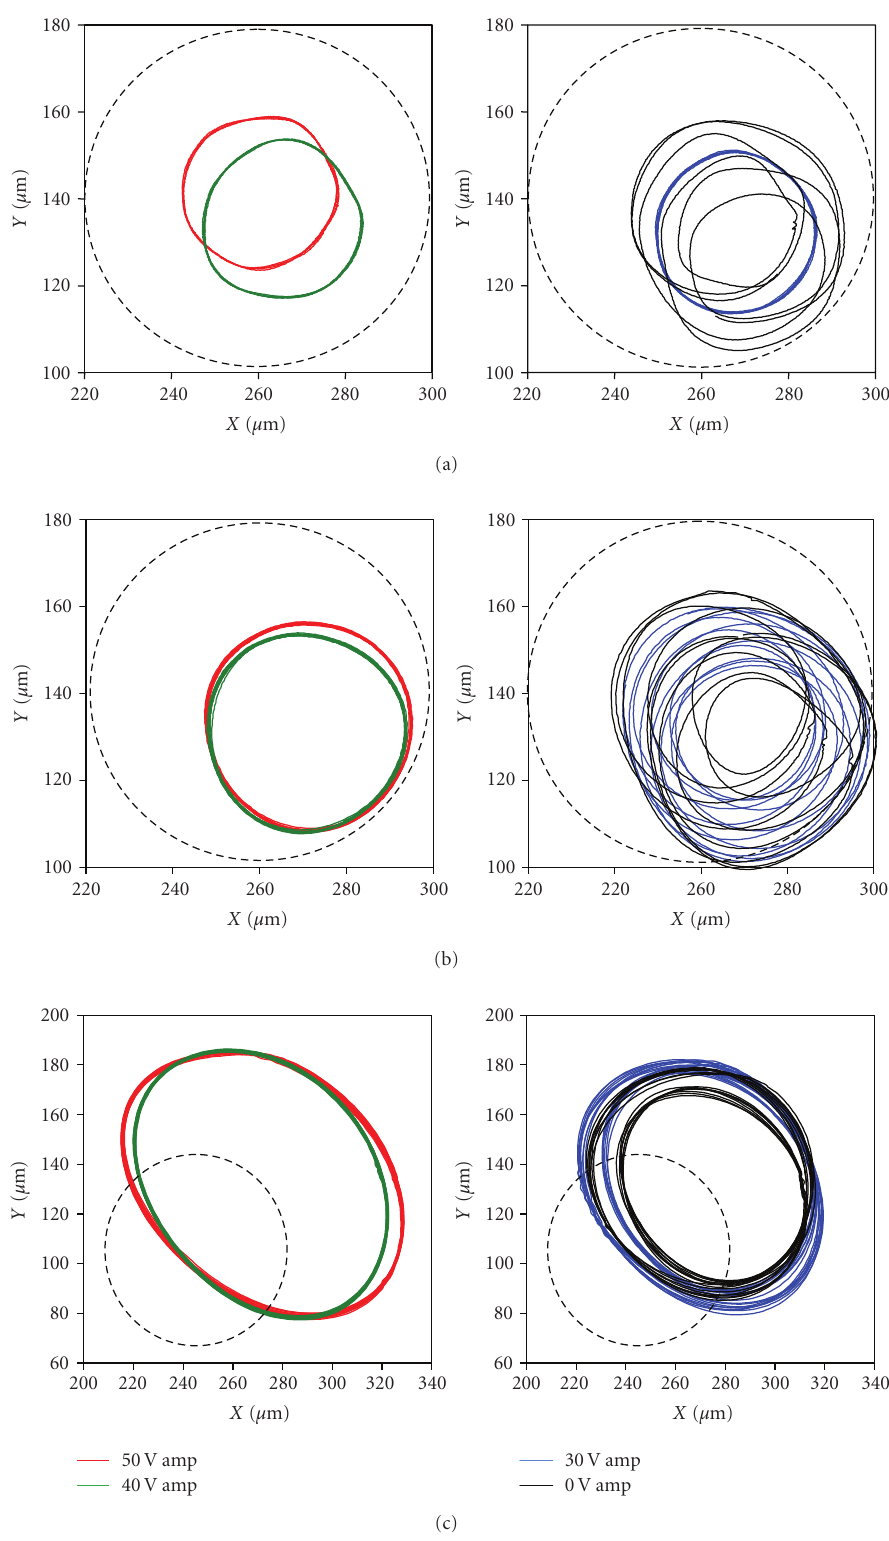
Figure 7: Rotor orbits with squeeze-film e ff ect, ω = 1500Hz, zero load: (a) Ω = 320rpm, (b) Ω = 630rpm, and (c) Ω =